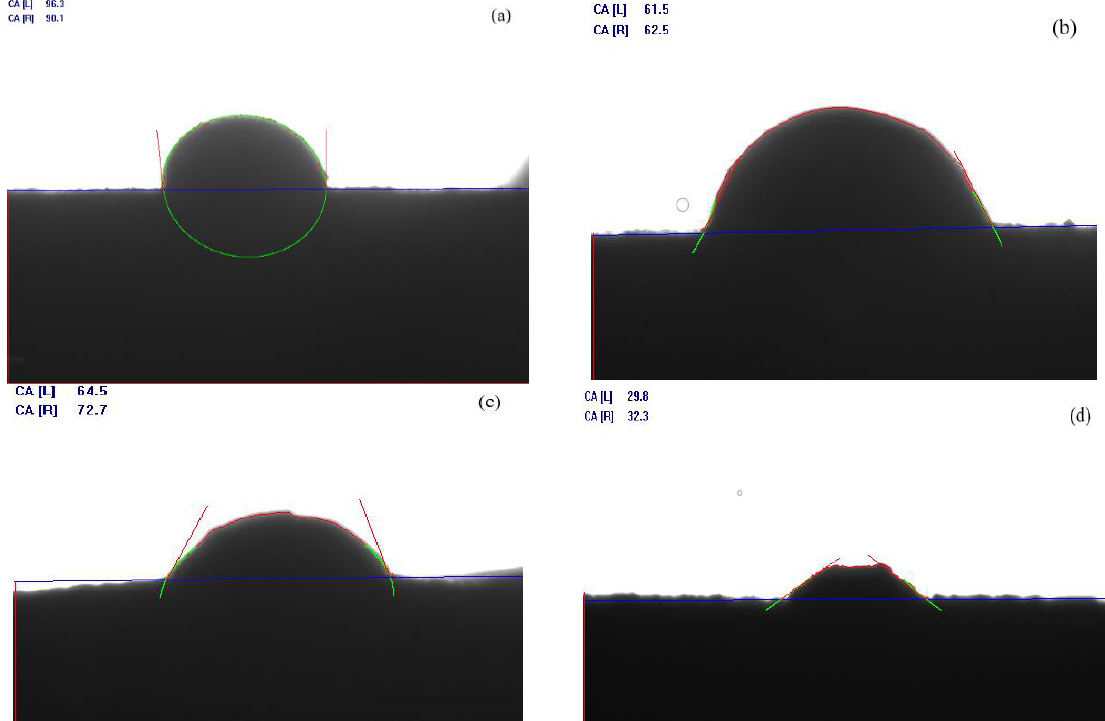
Figure 5. Wetting angle test results: ( a ) SnO 2 ; ( b ) Y-doped SnO 2 ; ( c ) Mo-doped SnO 2 ; ( d ) Y-Mo co-doped SnO 2 .